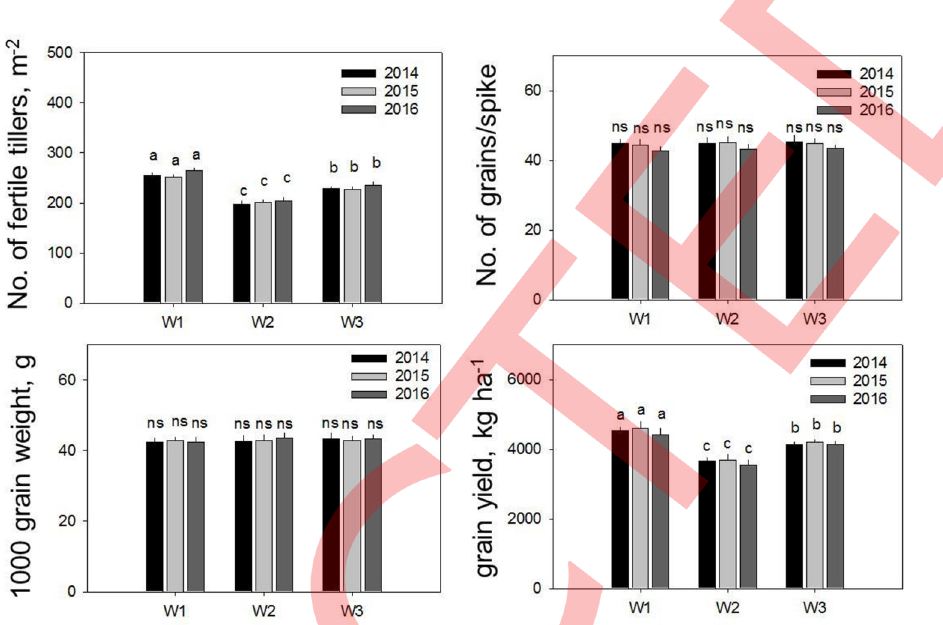
Fig 2. Grain yield and yield components of wheat sown in under different planting techniques. In X-axis legend, W 1 = conventional wheat sowing in 22.5 cm spaced rows, W 2 = every 4 th wheat row skipped and W 3 = every 7 th wheat row skipped for relay cropping of cotton in wheat.